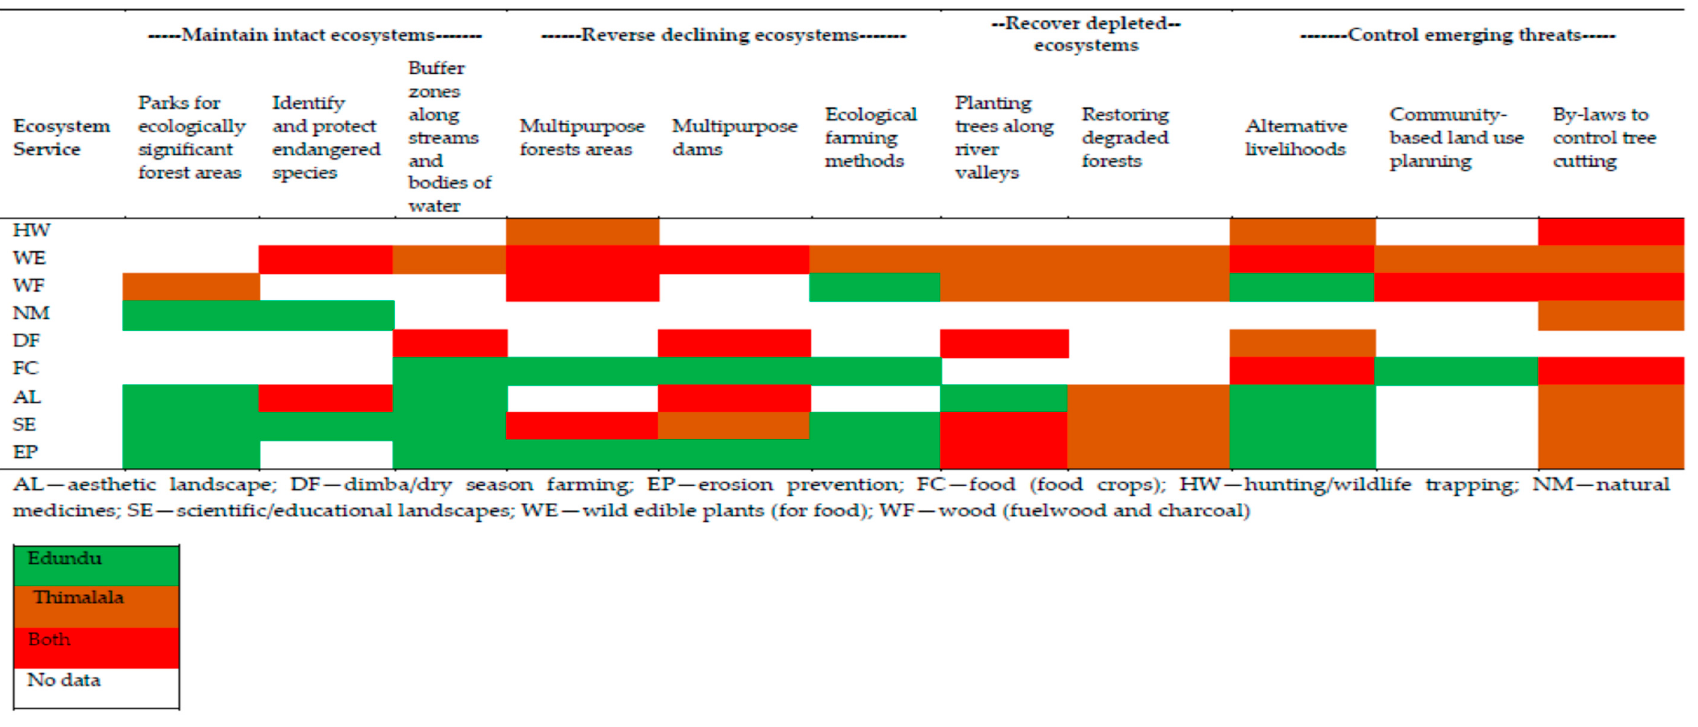
Figure 9. Prioritization of biodiversity conservation strategies based on ES mapping activities with farmers.